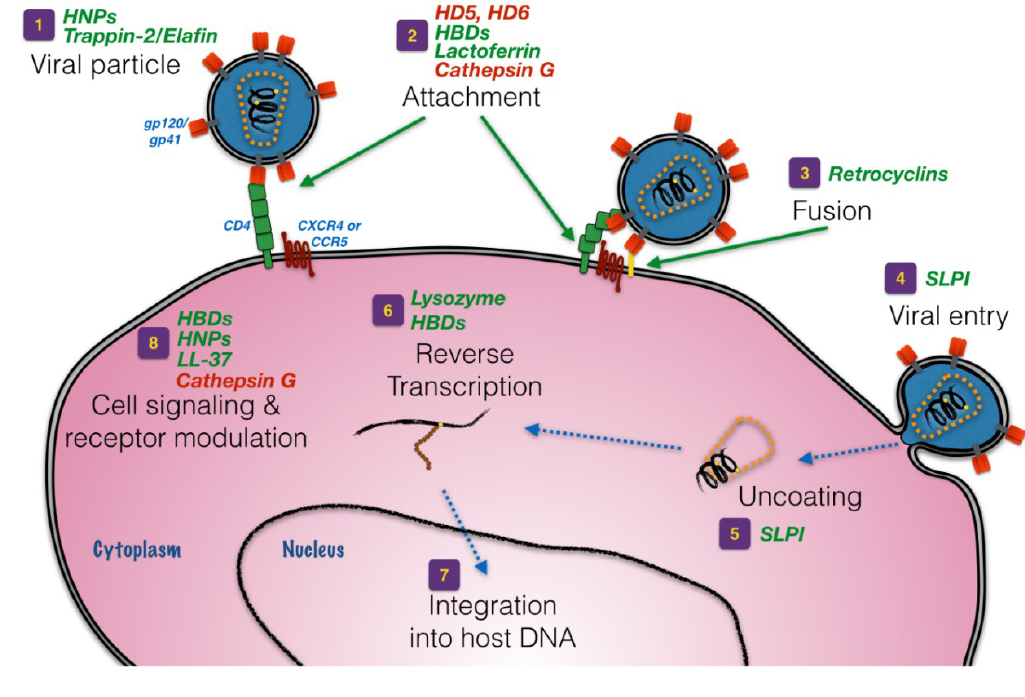
Figure 1. Anti-HIV-1 mechanisms of action of cationic peptides and peptides of the female reproductive tract (FRT). Depicted is the lifecycle of HIV-1 infecting a target CD4 + cell, beginning from a free virion (“1”) to integration of viral cDNA into genomic DNA of the target cell (“7”); “8” indicates other aspects, including receptor downmodulation and cell signaling, that indirectly affect the ability of the virus to infect or propagate within host cells. Cationic peptides and proteins in green font are antiviral at the respective stage in the lifecycle, while peptides and proteins in red font promote HIV-1 infection. Viral envelope proteins (gp120, gp41), cellular receptor (CD4) and coreceptor (CXCR4 or CCR5) required for viral attachment and entry are provided. Events downstream of viral cDNA